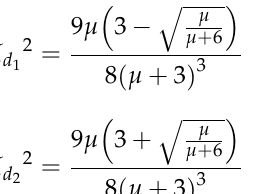
Using the values of f opt and ζ d cient can be calculated as